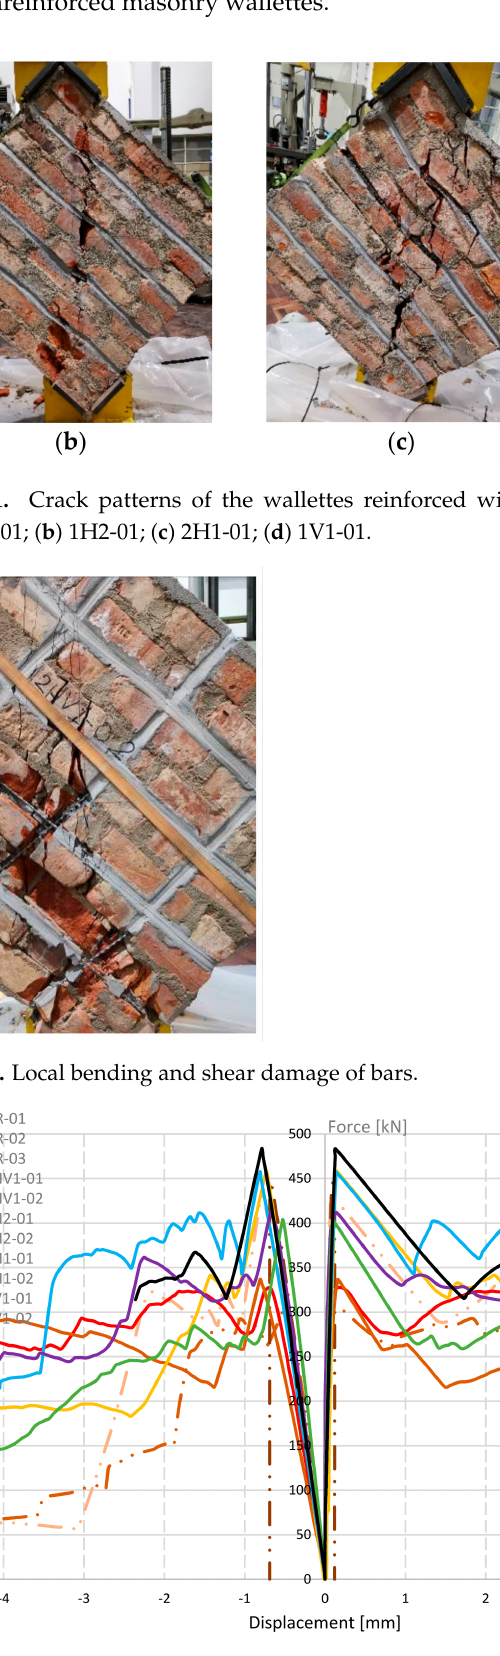
Figure 13. Force-displacement of TSB reinforced vs. UR